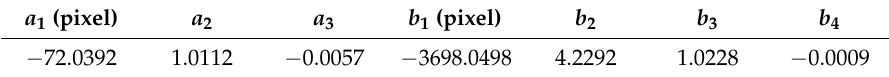
Table 2. Parameters of the geometric transformation estimated by least squares